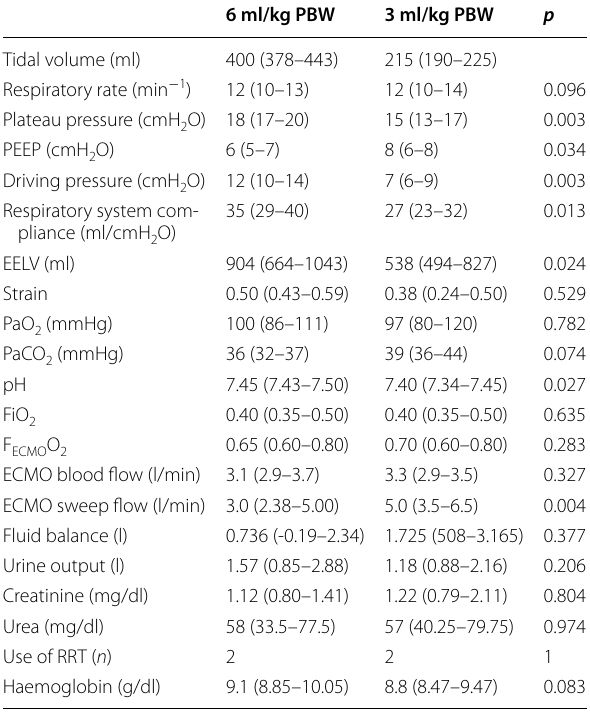
Table 1 Respiratory mechanics and gas exchange during ventilation with tidal volumes of 6 and 3 ml/kg